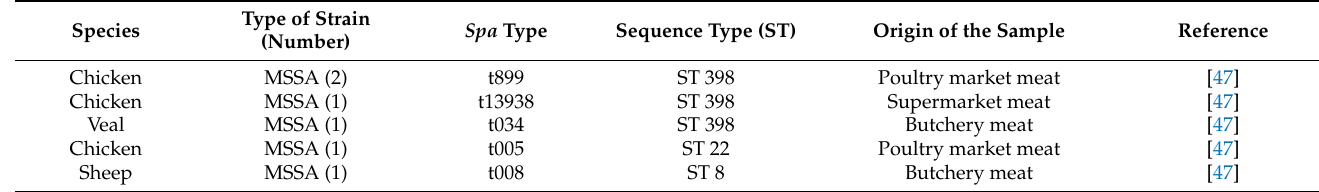
Table 7. Sequence type of meat isolates from